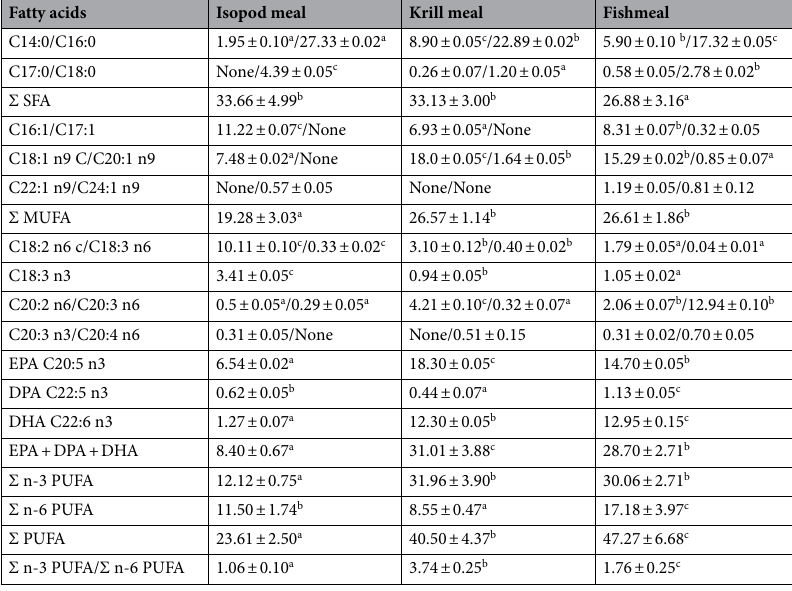
Table 4. Fatty acids content of isopod meal, Antarctic krill meal and fishmeal. Numerical values marked with the same letter a, b or c are not statistically significantly different. SFA saturated fatty acids, MUFA monounsaturated fatty acids, PUFA polyunsaturated fatty acids, ND not detected.